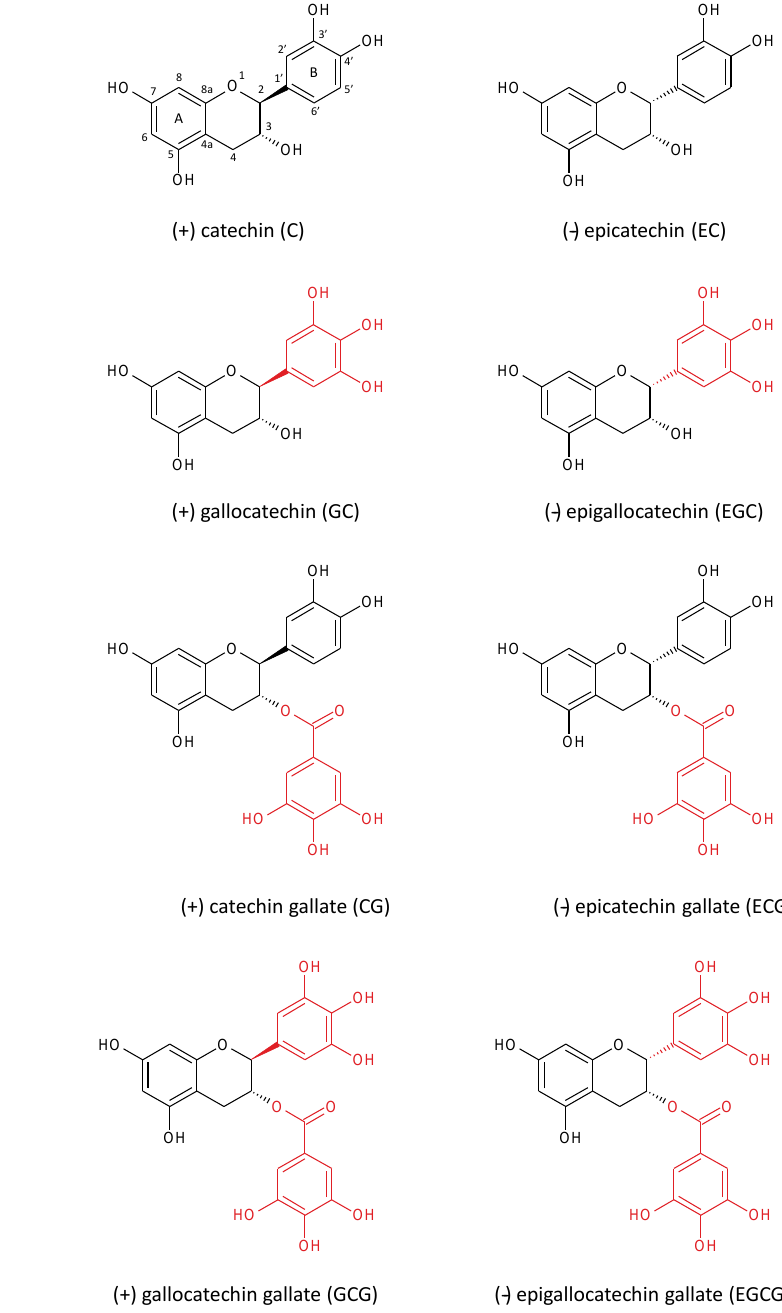
Figure 1. Molecular structure of gallic acid and catechins.